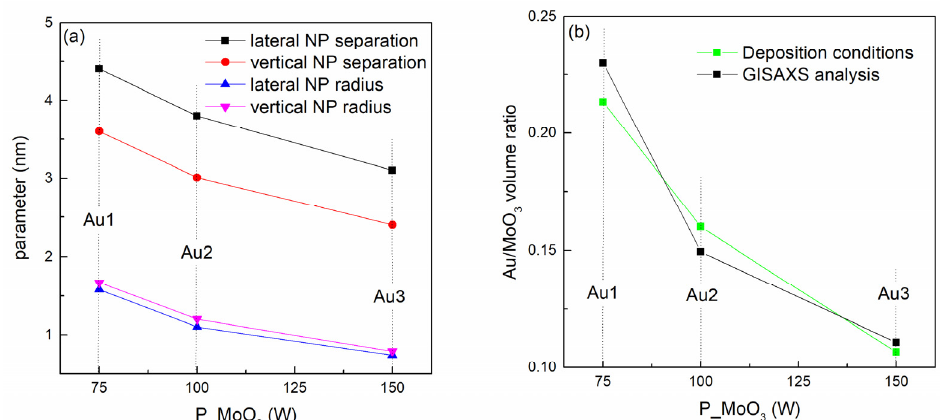
Figure 2. ( a ) Structural parameters of the films obtained by GISAXS analysis. ( b ) Ratio of the volumes of the Au nanoparticles and MoO 3 matrix calculated from GISAXS parameters and from the deposition conditions (sputtering powers of Au and MoO 3 ).